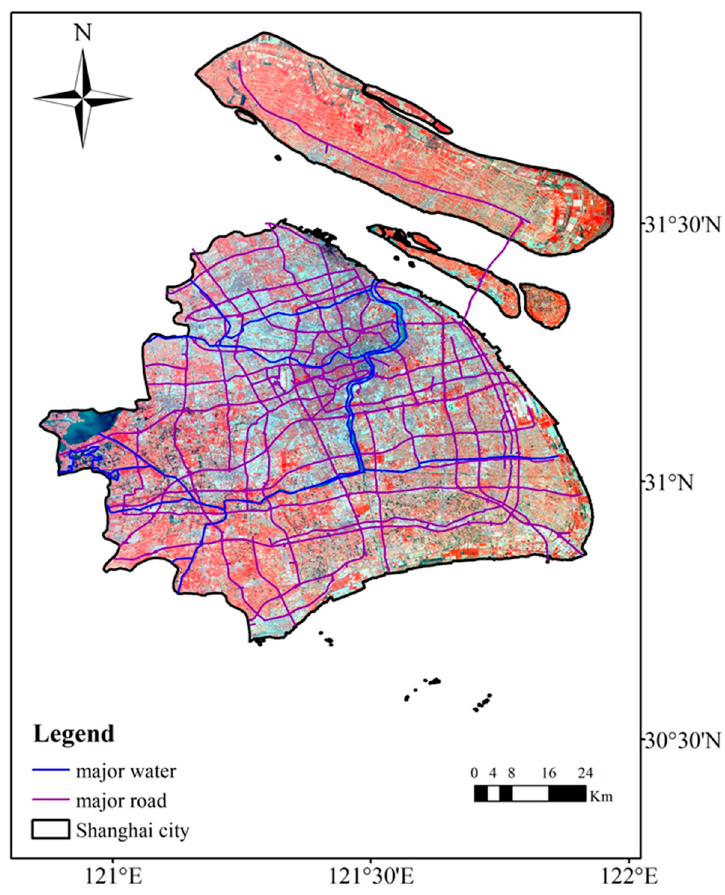
Figure 1. Study area in Shanghai, China.